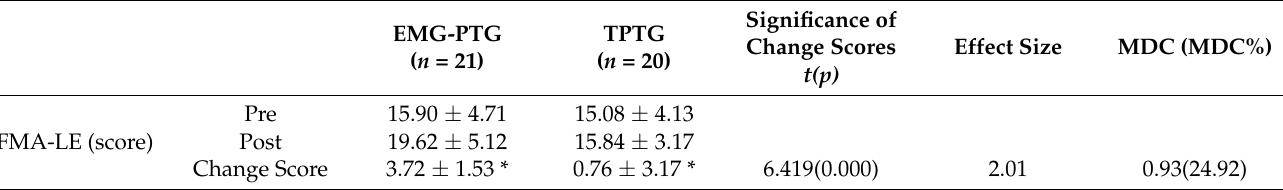
Table 4. Changes in lower extremity motor